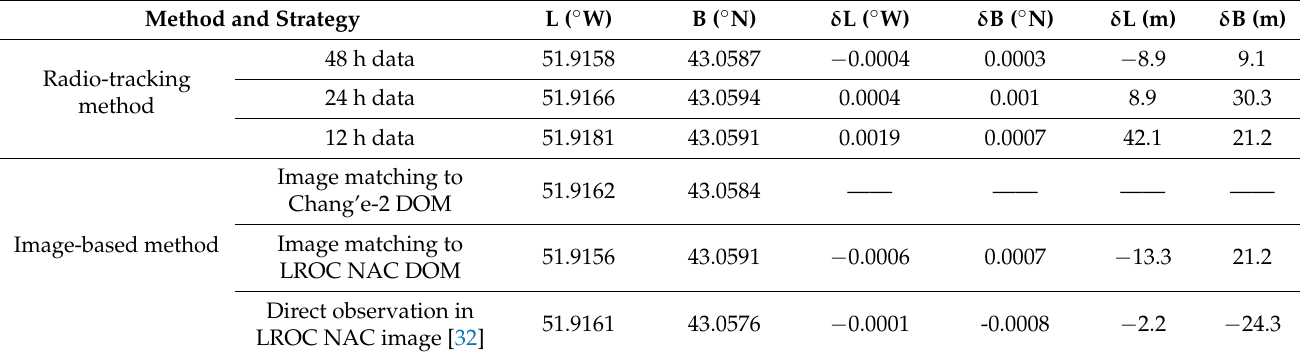
Table 1. Lander localization results and